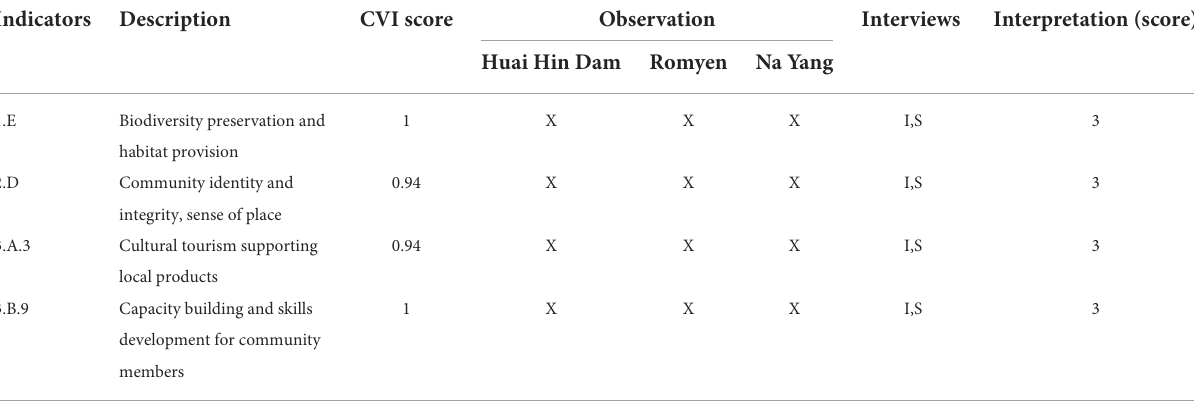
TABLE 5 Prioritized research findings with a high value of 3 (source: authors).